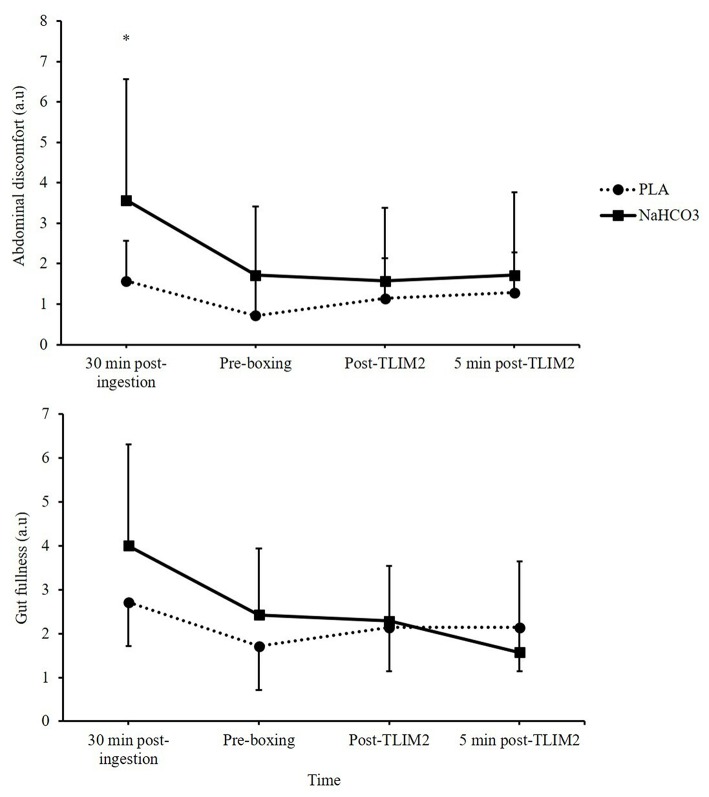
Gastrointestinal (GI) discomfort (gut fullness and abdominal discomfort) following NaHCO3 or PLA. *NaHCO3 greater than PLA (p < 0.05).